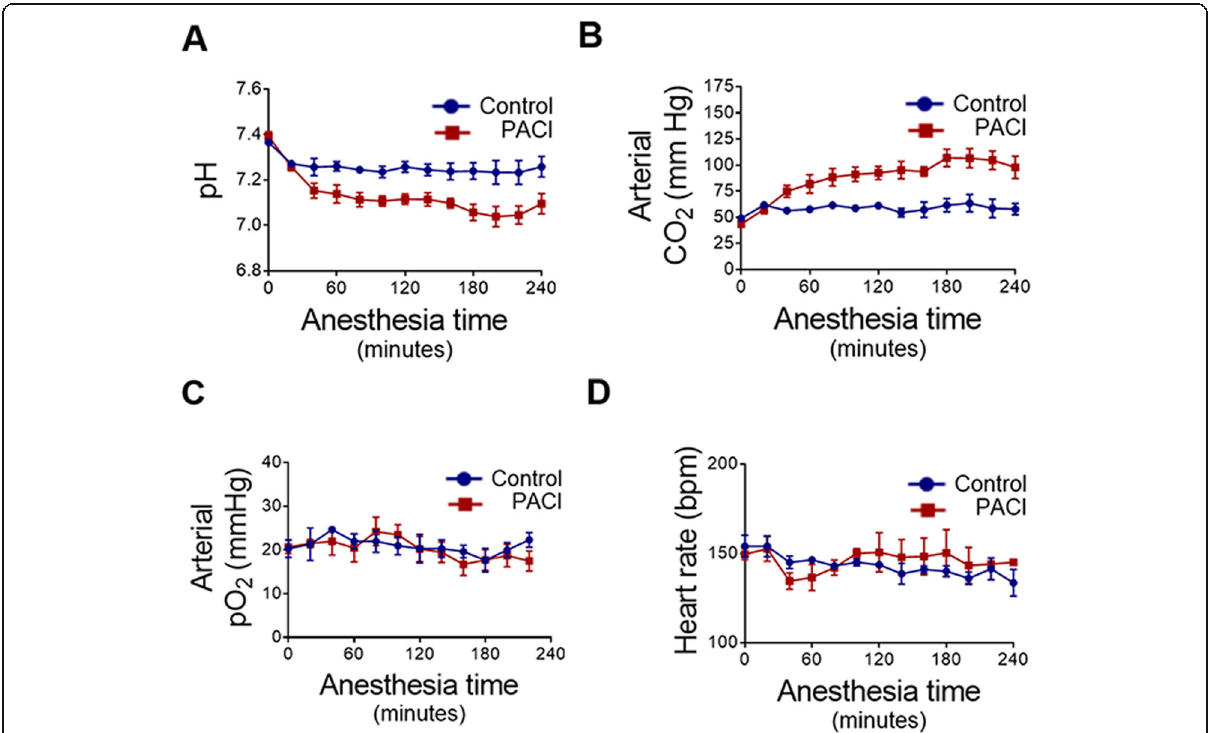
Fig. 6 Evaluation of serum laboratory values and fetal heart rate in non-insufflated control fetuses (n = 3) and insufflated fetuses (n = 4) over time. In utero a , pH and b , arterial carbon dioxide levels increased significantly in insufflated fetuses versus non-insufflated control fetuses. c Oxygen levels and d , heart rate were unchanged in insufflated fetuses versus non-insufflated control fetuses. Data shown as mean ± standard